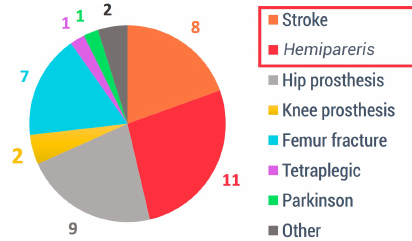
Figure 16. Classification of the diseases affecting the patients that tested the ReMoVES platform. The patients affected by hemiparesis are a subcategory of the ones affected by stroke (red